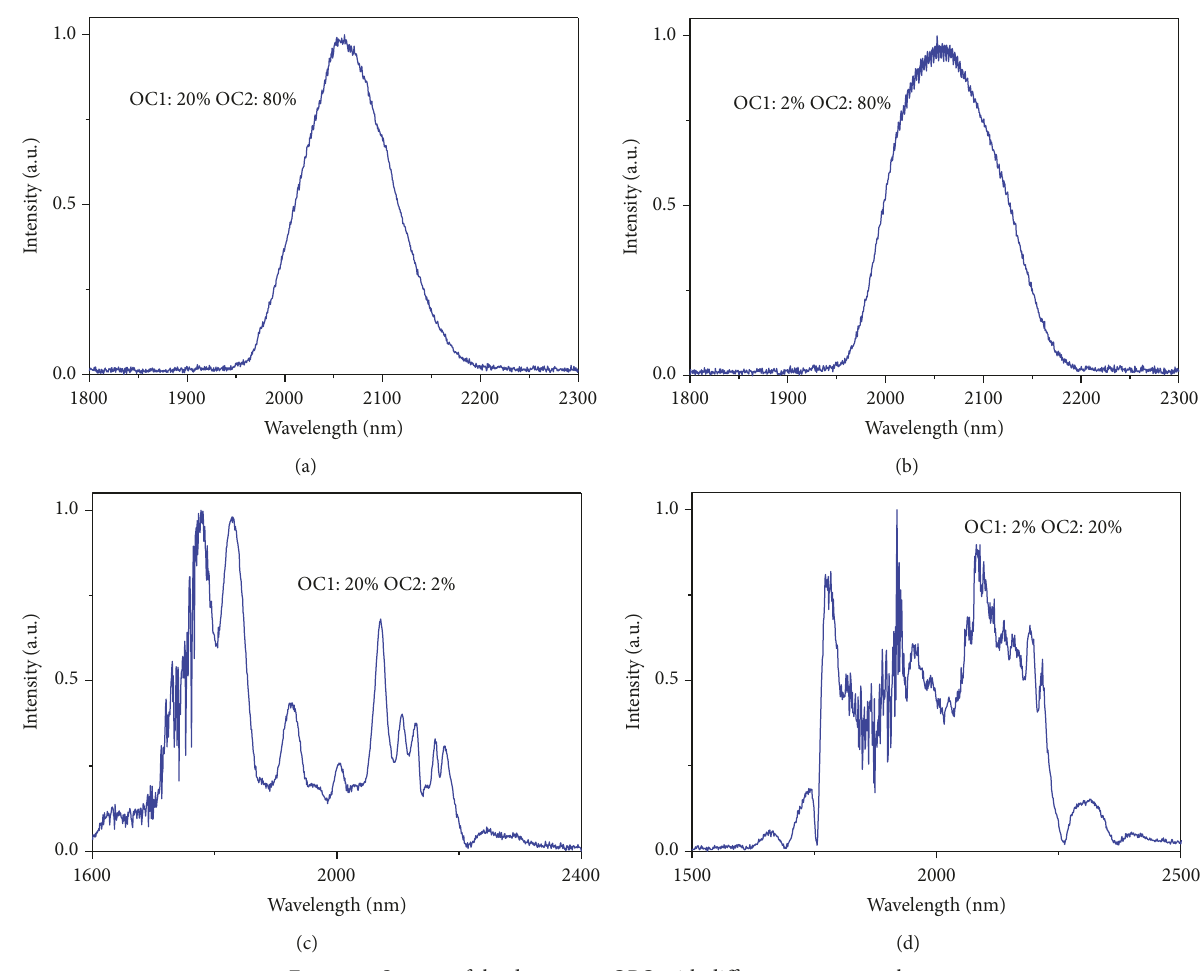
Figure 5: Spectra of the degenerate OPO with different output